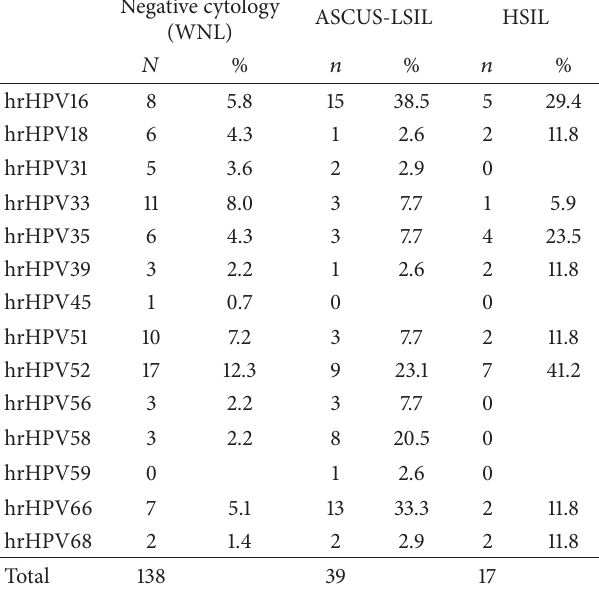
Table 4: Cytology score versus